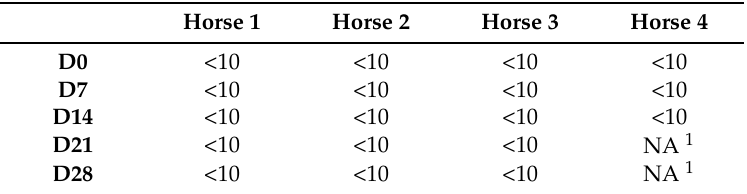
Table 3. Neutralizing antibody titers in horses experimentally infected with MERS-CoV. Titers were determined by PRNT using a 90% cutoff. Horse 1 Horse 2 Horse 3 Horse